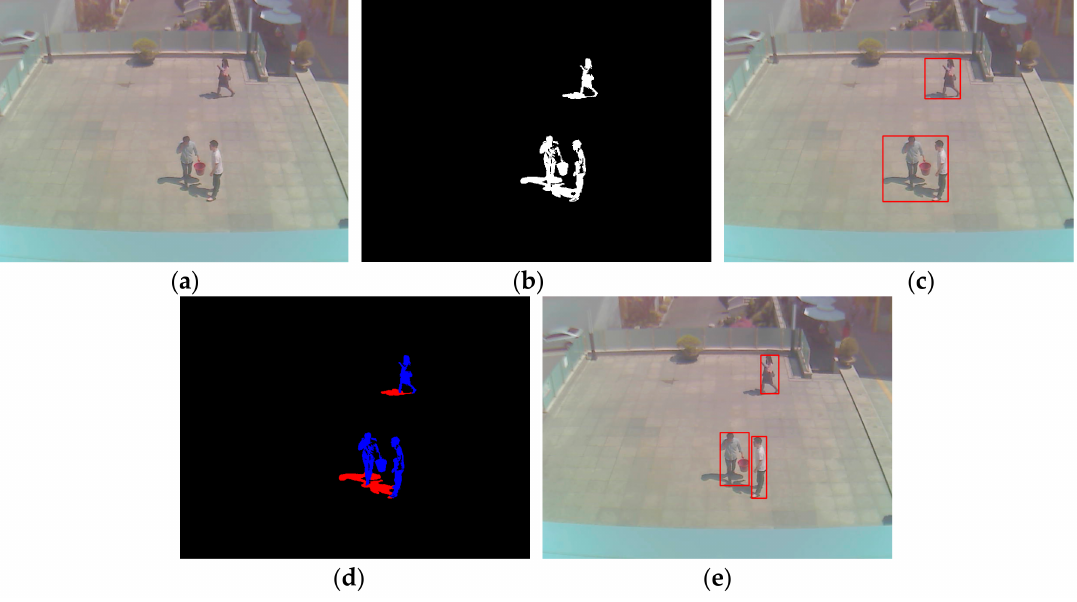
Figure 7. Examples of resultant images of each phase, which are obtained via the proposed method. ( a ) Input image; ( b ) Foreground area obtained by background subtraction; ( c ) Detected box of foreground area; ( d ) Detected shadow (red color) and non-shadow (blue color) regions by our method; ( e ) Final result of non-shadow (human) area excluding shadow